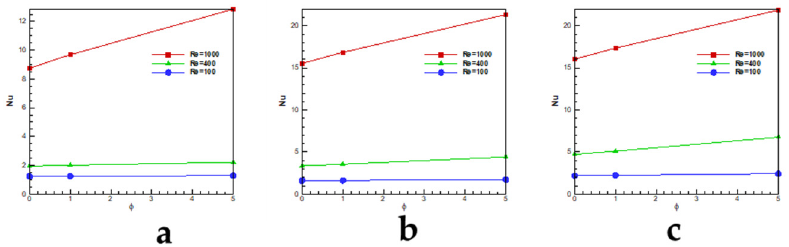
Figure 9. Variation of averaged Nusselt number, at different nanoparticles volume concentration at HR = 2. ( a ) Ra = 10 4 , ( b ) Ra = 10 5 , ( c ) Ra = 10 6 .